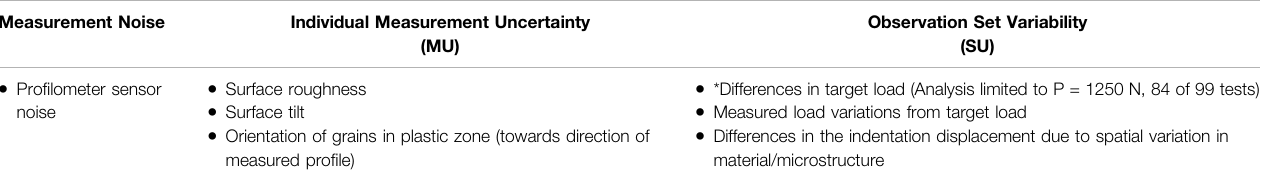
TABLE 1 | A summary of the likely contributing factors pertaining to each of the categories of uncertainty present in the experimental data set. The in fl uence of the factor marked with an asterisk is not examined in this work. Measurement Noise Individual Measurement Uncertainty Observation Set Variability (MU)